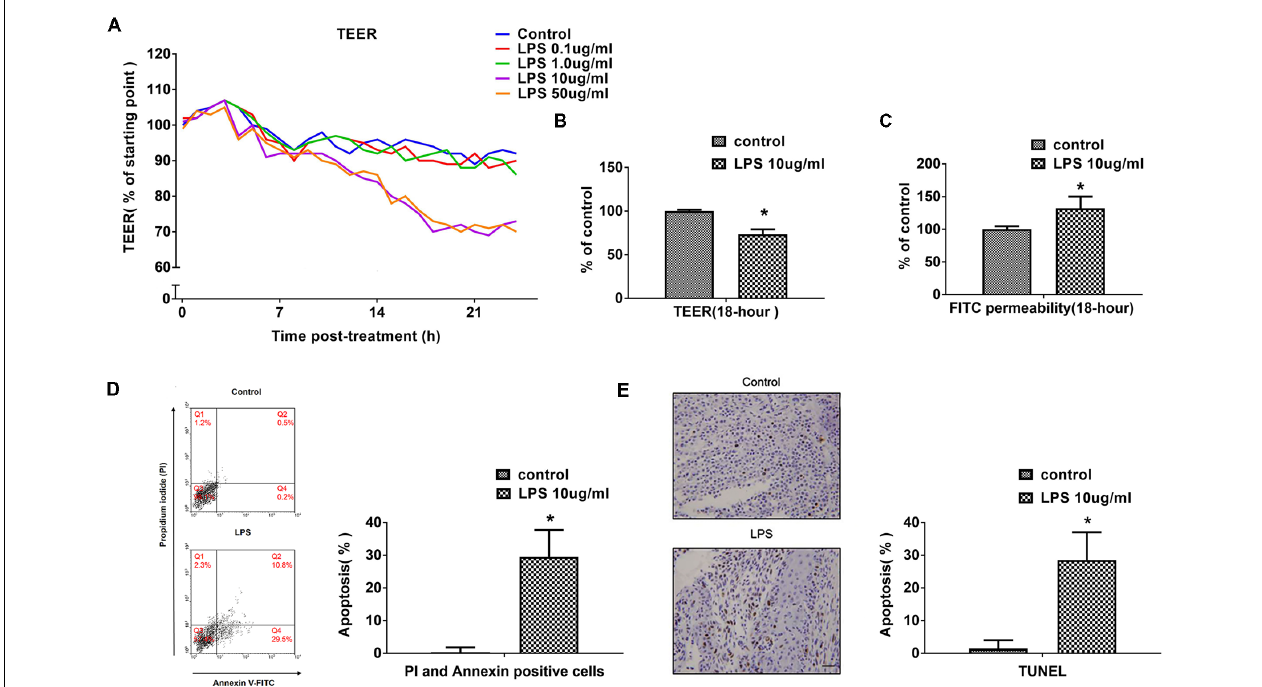
FIGURE 1 | LPS induces human cerebral microvascular endothelial cell line (hCMEC/D3) cell apoptosis and affects blood-brain-barrier (BBB) permeability in a dose- and time-dependent manner. (A) The effects of different concentrations of LPS (0–50 µ g/mL) on BBB integrity was determined in vitro by measuring trans-endothelial electrical resistance (TEER) over a 24-h experimental period. (B) Effects of 10 µ g/mL LPS on TEER after 18-h treatment. (C) Effects of 10 µ g/mL LPS on paracellular permeability to FITC- (4kDa) dextrans across hCMEC/D3 monolayers after 18-h treatment. (D) Effects of LPS on early cell apoptosis as determined by flow cytometry; quantitative analysis of the percentage of apoptotic cells was calculated. (E) Effects of LPS on cell apoptosis as determined by TUNEL assay. Apoptotic cells appear brown and the nucleus appear blue. Scale bar, 200 µ m; quantitative analysis of the percentage of apoptotic cells was calculated. ∗ P < 0.01, vs. control.